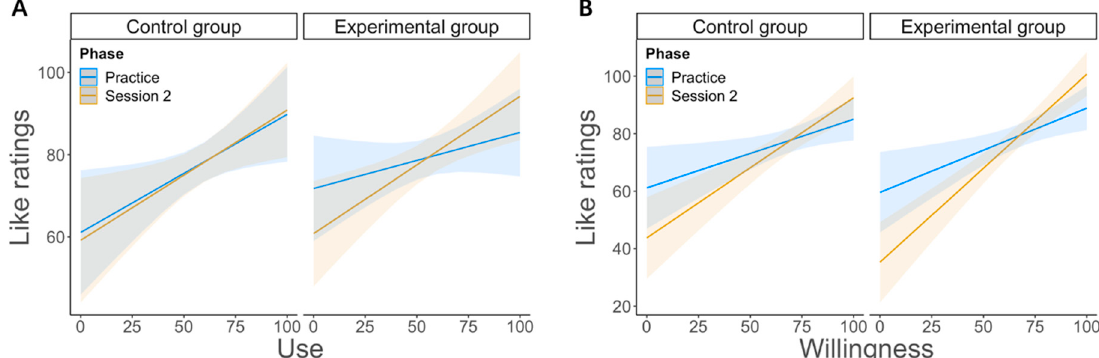
Figure 4. Like ratings were modulated by the perceived emotion regulation. ( A ) Like ratings increased when the perceived use increased as well. ( B ) The same was found for the perceived willingness.